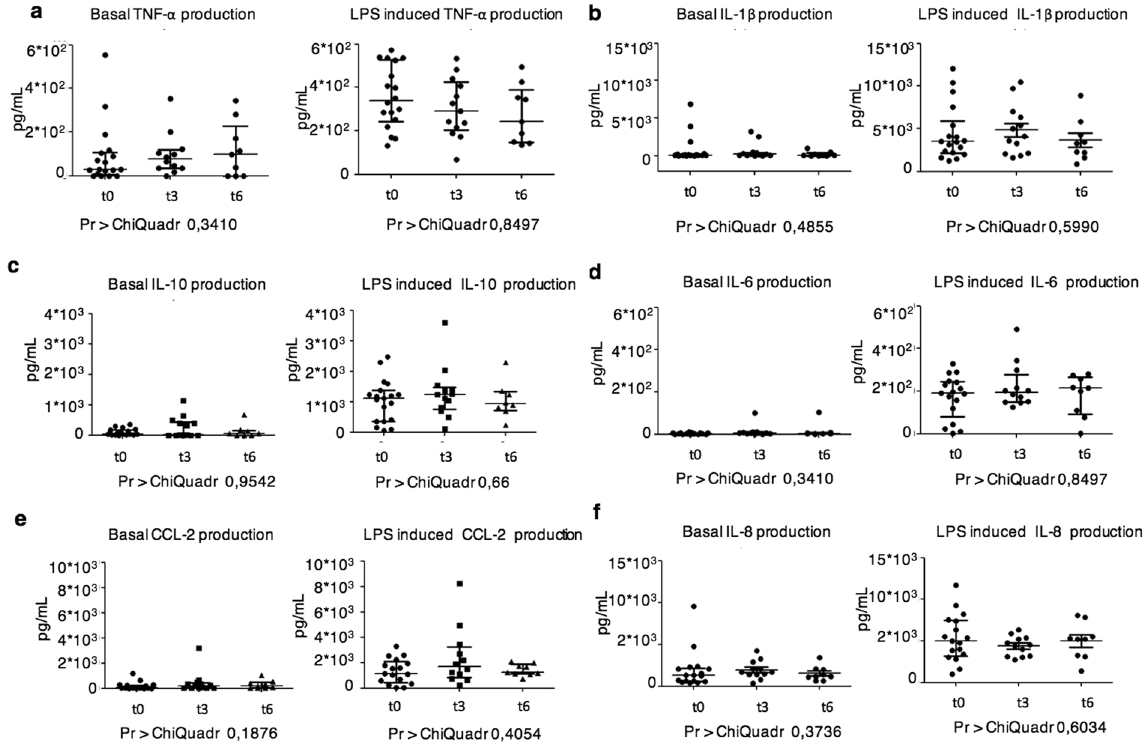
Figure 4. Longitudinal analysis of cytokine production. Scatter plots of the amounts of the indicated cytokines produced by DCs from ALS, HD and ODN 24 h after in vitro culture in the presence or absence of LPS. Three time points are shown, the first measure (t0) and the analyses performed 3 months (t3) and 6 months (t6) after the first